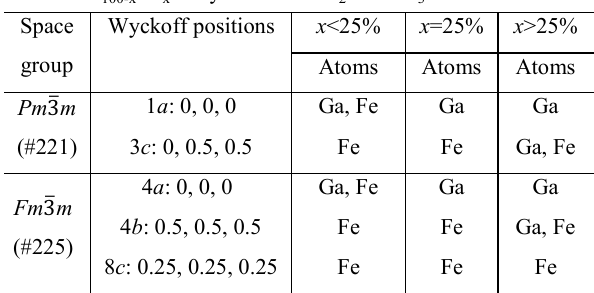
Table 1. The atomic distribution for off-stoichiometric Fe 100-x Ga x alloys with the L1 2 and D0 3 structures